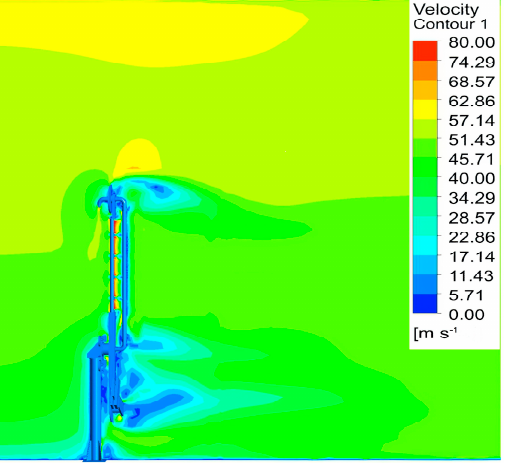
Figure 15. Velocity cross-section of the LNG marine loading arm flow field.